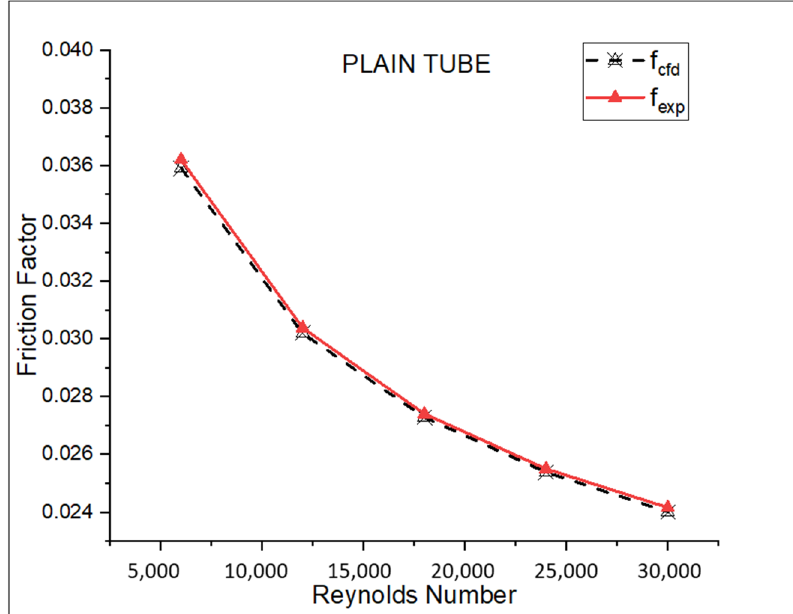
Figure 8. Study of f over Reynolds Number.